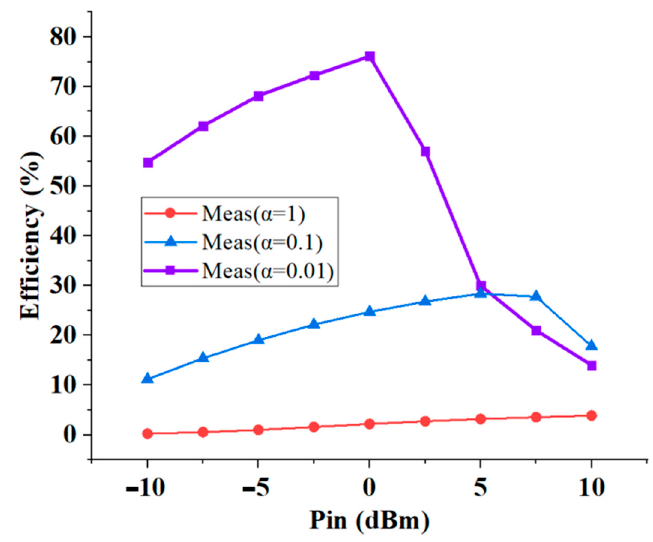
Figure 10. Measurement of rectifying efficiency at the same load resistance.